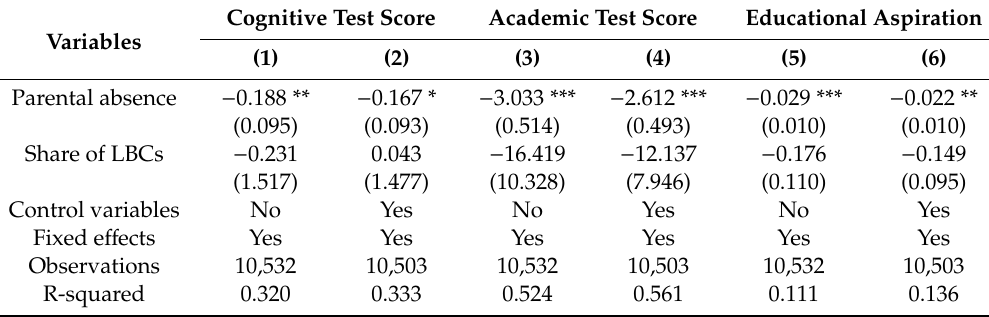
Table 4. E ff ects of parental absence on students’ academic outcomes.